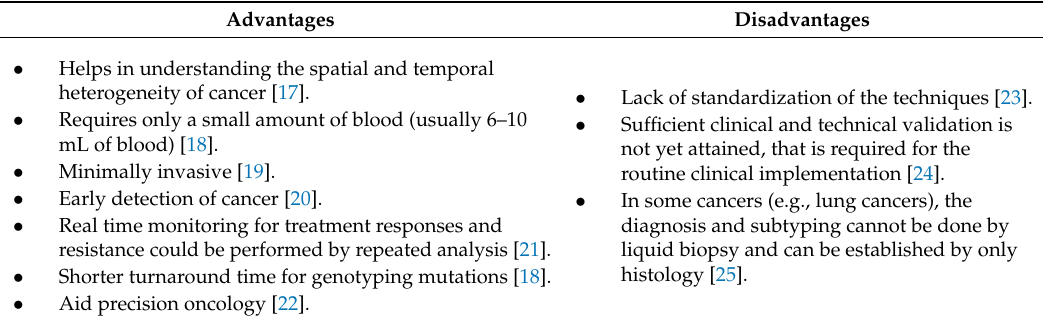
Table 1. Advantages and disadvantages of liquid